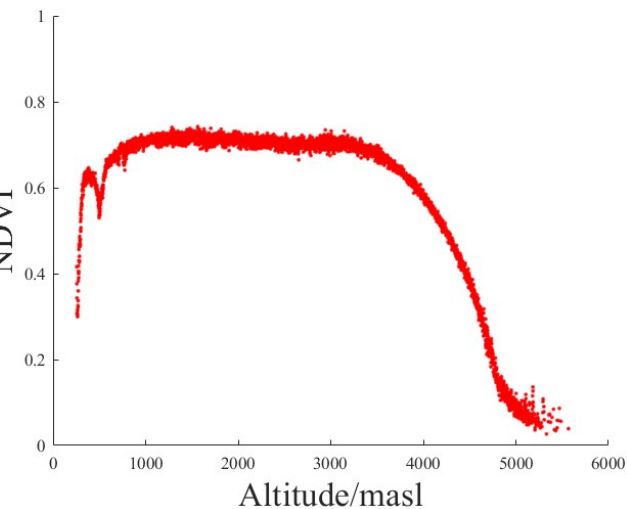
Figure 8. Relationship between NDVI and altitude in the growing season in the Minjiang River Basin from 2001 to 2020.